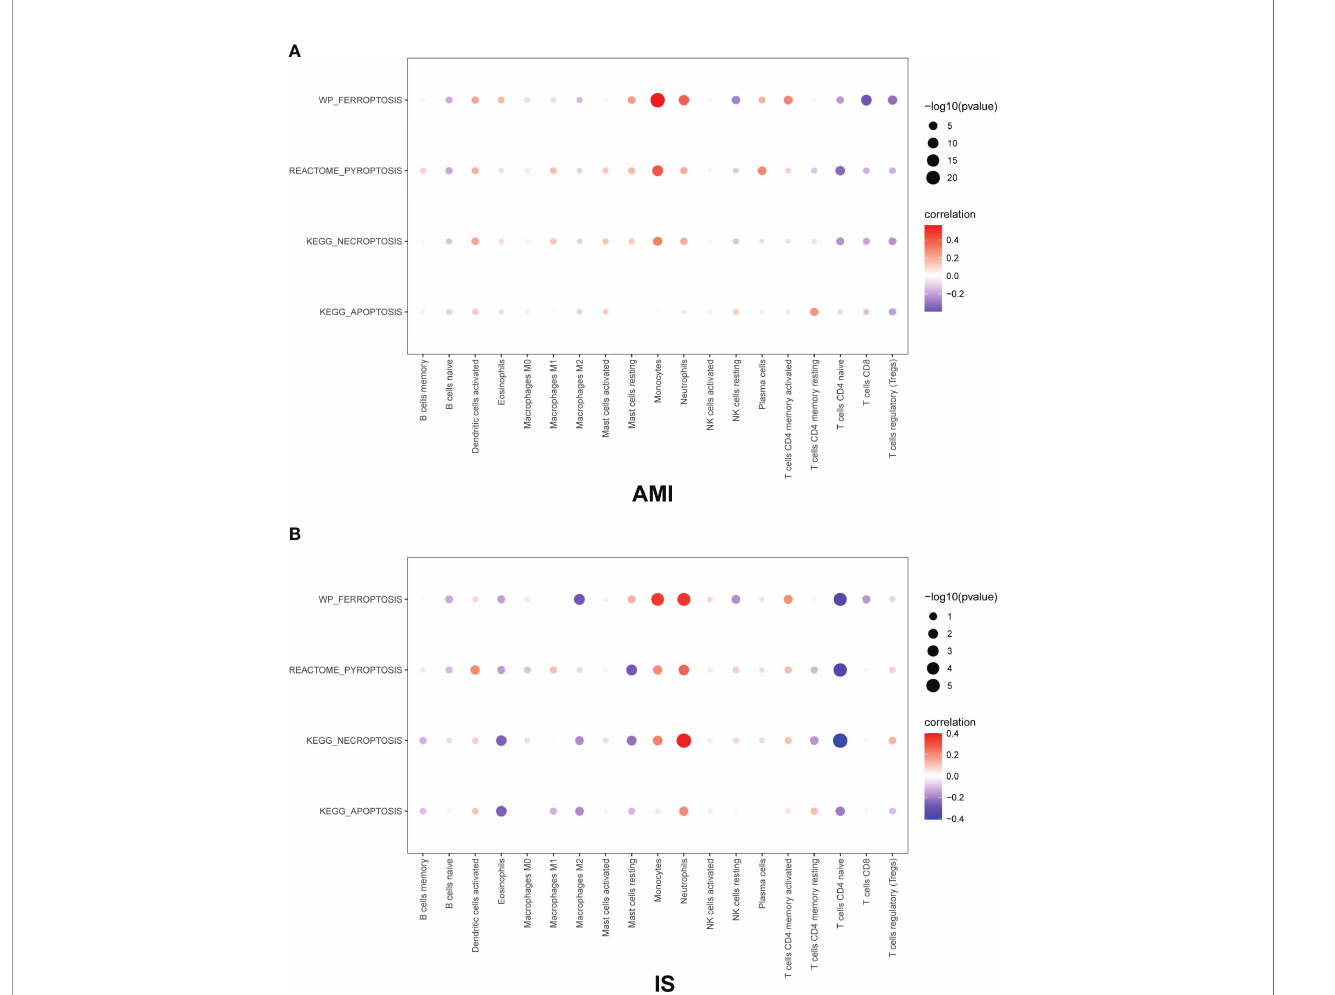
FIGURE 7 | Pearson correlation coef fi cient between immune cells and cell death in (A) AMI and (B) IS. The Pearson correlation coef fi cient was determined by Pearson correlation analysis and the P -values were calculated by t